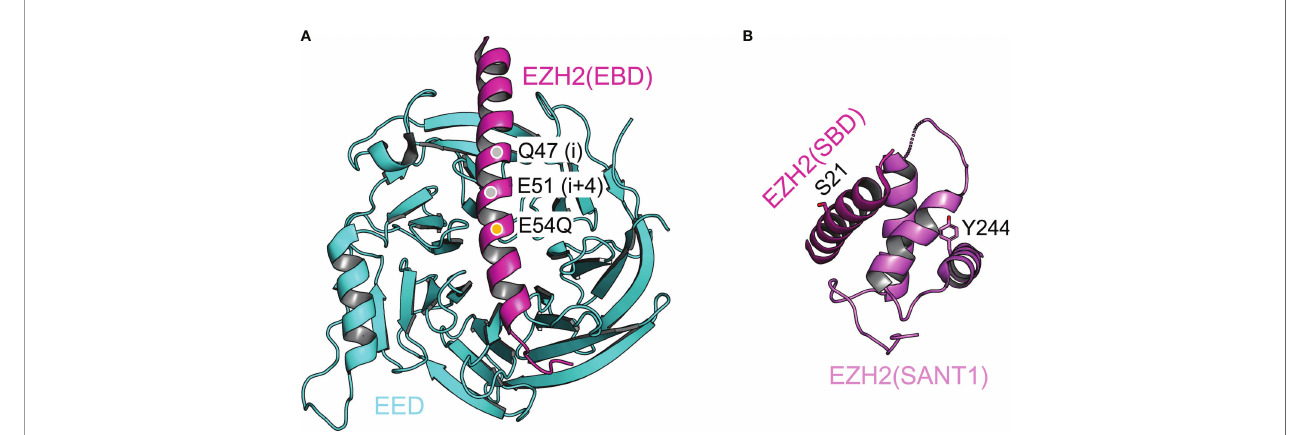
FIGURE 4 | Structural dissection of the complex assembly of the catalytic module Structural features of the catalytic module are highlighted. (A) Structure of the EZH2(EBD) – EED complex (from PDB 5HYN). Q47 and E51 (gray discs) are the two residues at positions i and i+4, where a hydrocarbon staple is incorporated. E54Q mutation (orange disc) is introduced to enhance the cellular uptake of the stapled peptide. (B) Intramolecular complex of EZH2(SBD) and EZH2(SANT1). Residues S21 and Y244, which are phosphorylated in cancer cells, are labeled and shown as sticks